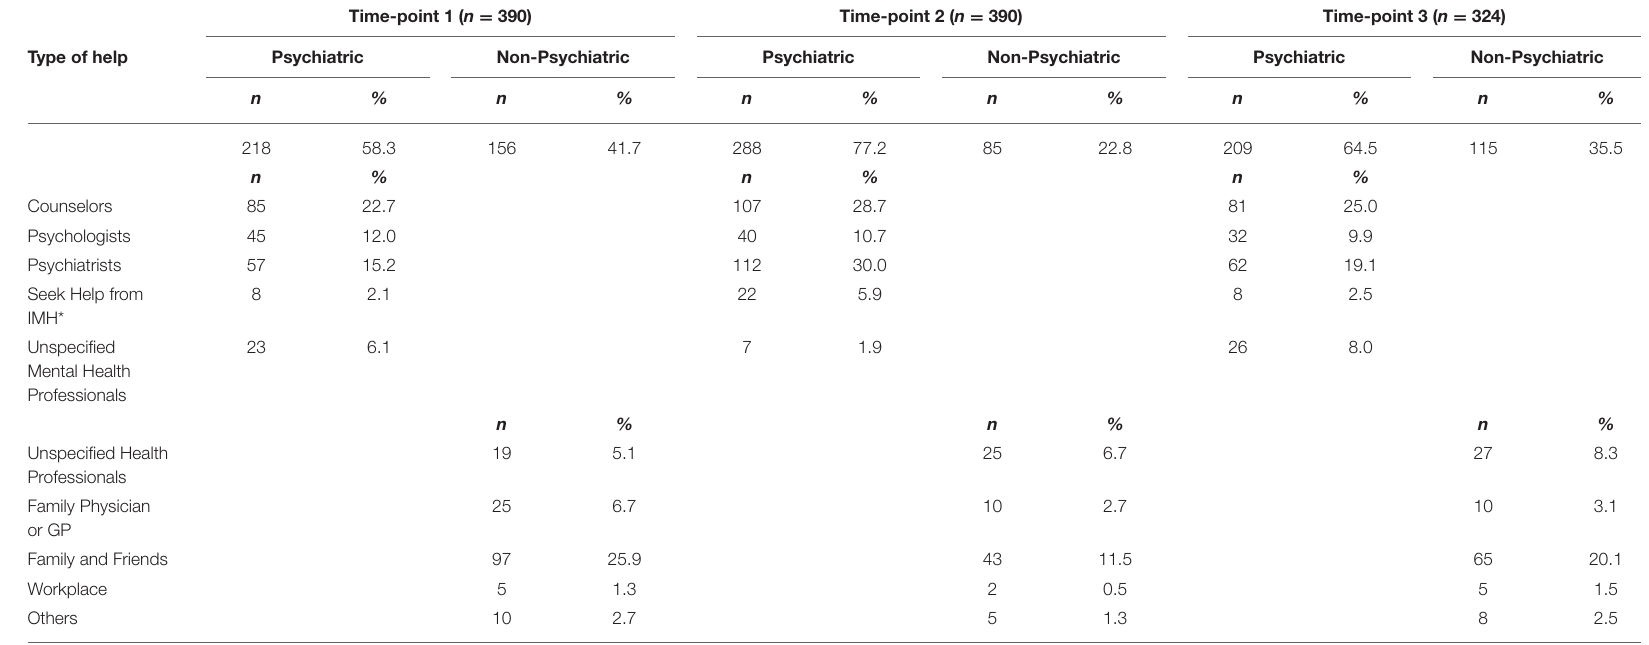
TABLE 3 | Students’ belief about where Adam should seek help from in pre (time-point 1) and post (time-point 2) intervention as well as 3-months (time-point 3) from intervention. Time-point 1 ( n =